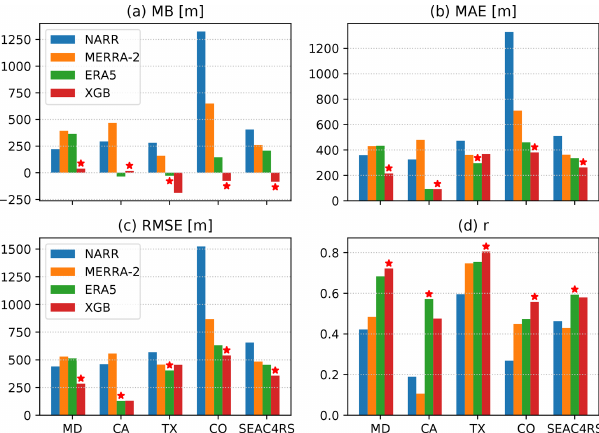
Figure 9. Similar to Fig. 7 but using the HSRL PBLH measure- ments during five airborne campaigns as the reference dataset. Each campaign corresponds to a cluster of bars in each